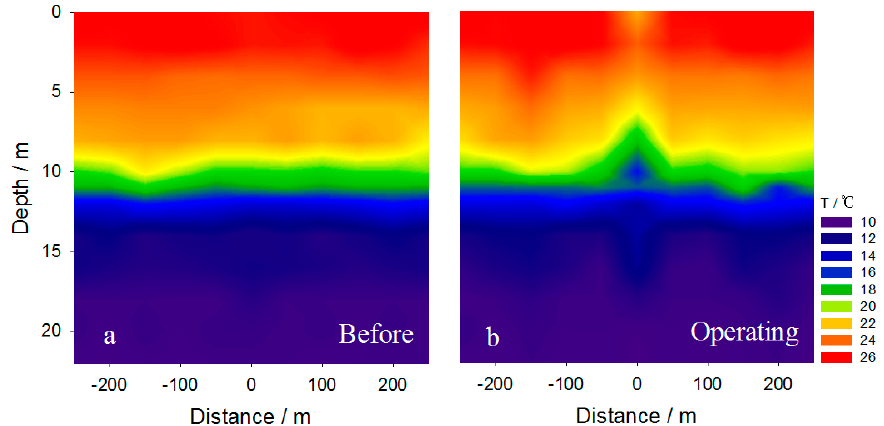
Figure 5. Spatial variation of temperature in the water column ( a ) before and ( b ) during operation of the apparatus.